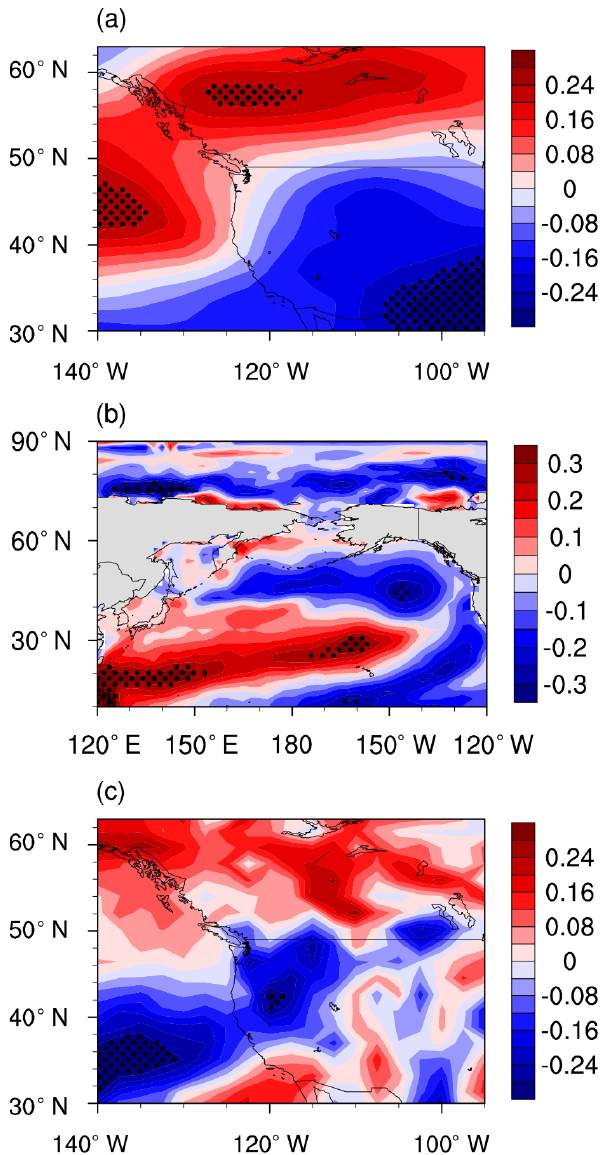
Figure 12. Correlation coefficients between the specified March ASO variations and simulated anomalies of April U (a) , SST (b) and precipitation (c) for the period 1955–2005, based on the tran- sient experiment R8. Regions above the 95% confidence level are dotted. The seasonal cycle and linear trend were removed from all quantities before correlation.